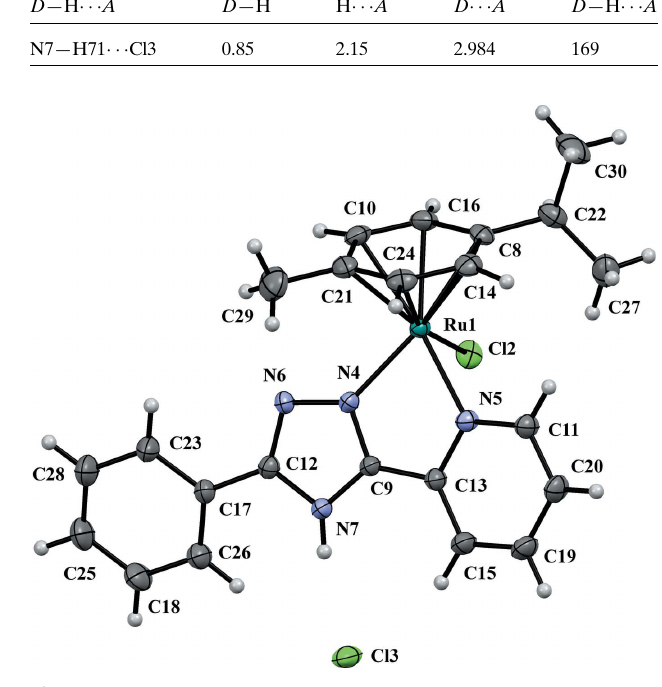
Figure 1 The title compound with displacement ellipsoids drawn at the 50% probability level. H atoms are shown as spheres of arbitrary radius.